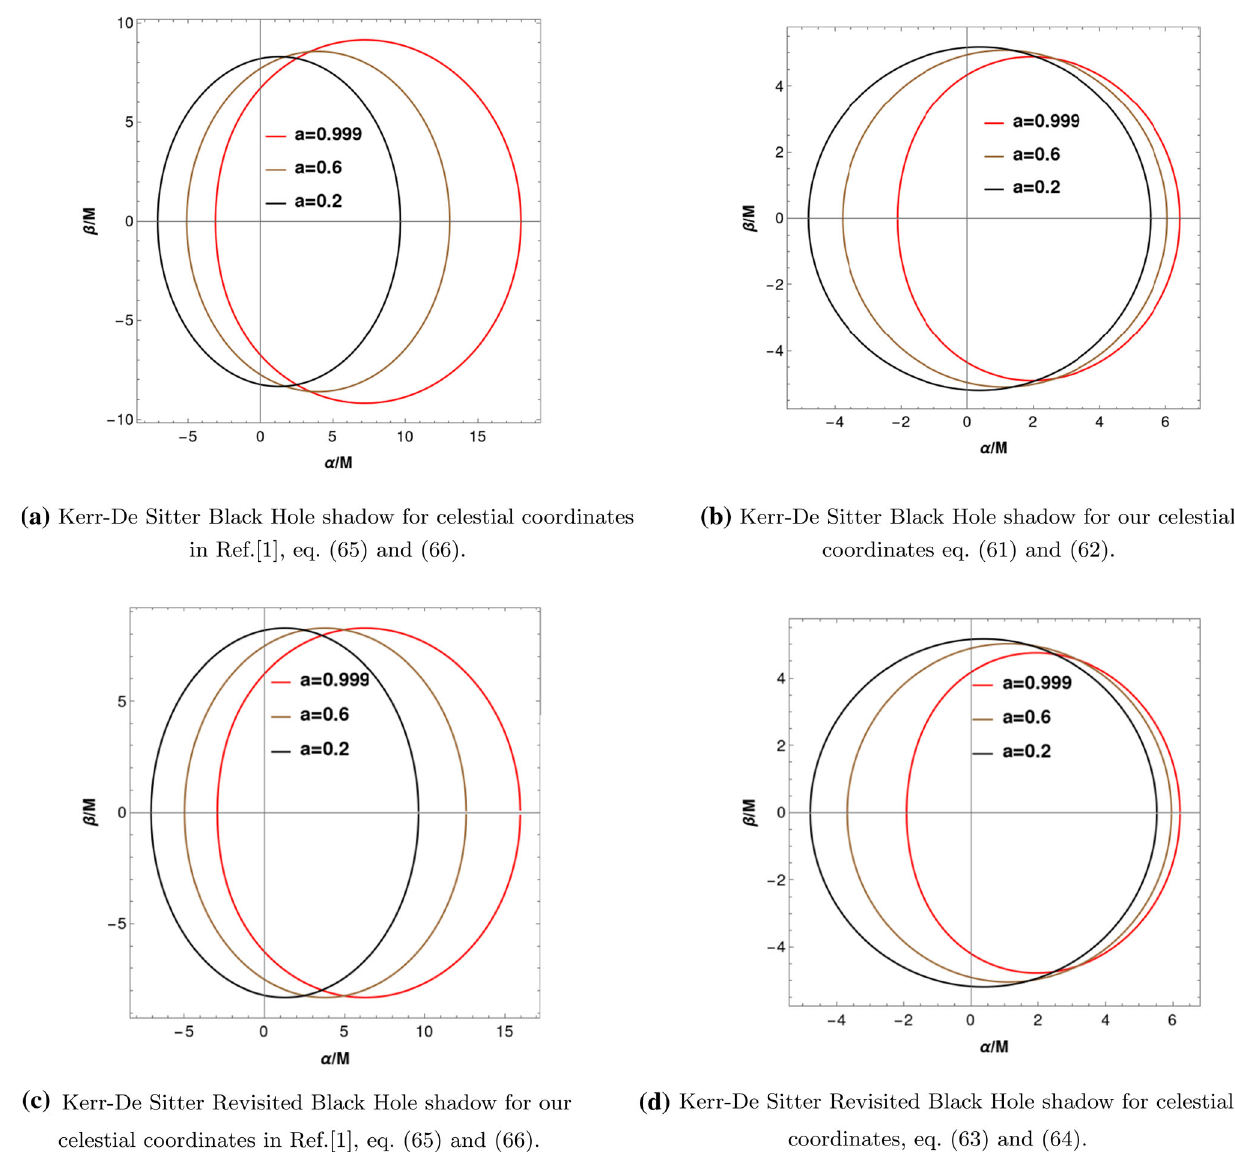
Fig. 5 Comparison of the shadows for impact parameter used in Ref. [1] with those that we obtain. We fix (cid:2) = 0 . 06 m − 2 , M = 1 . 06, θ = π/ 2, and vary a